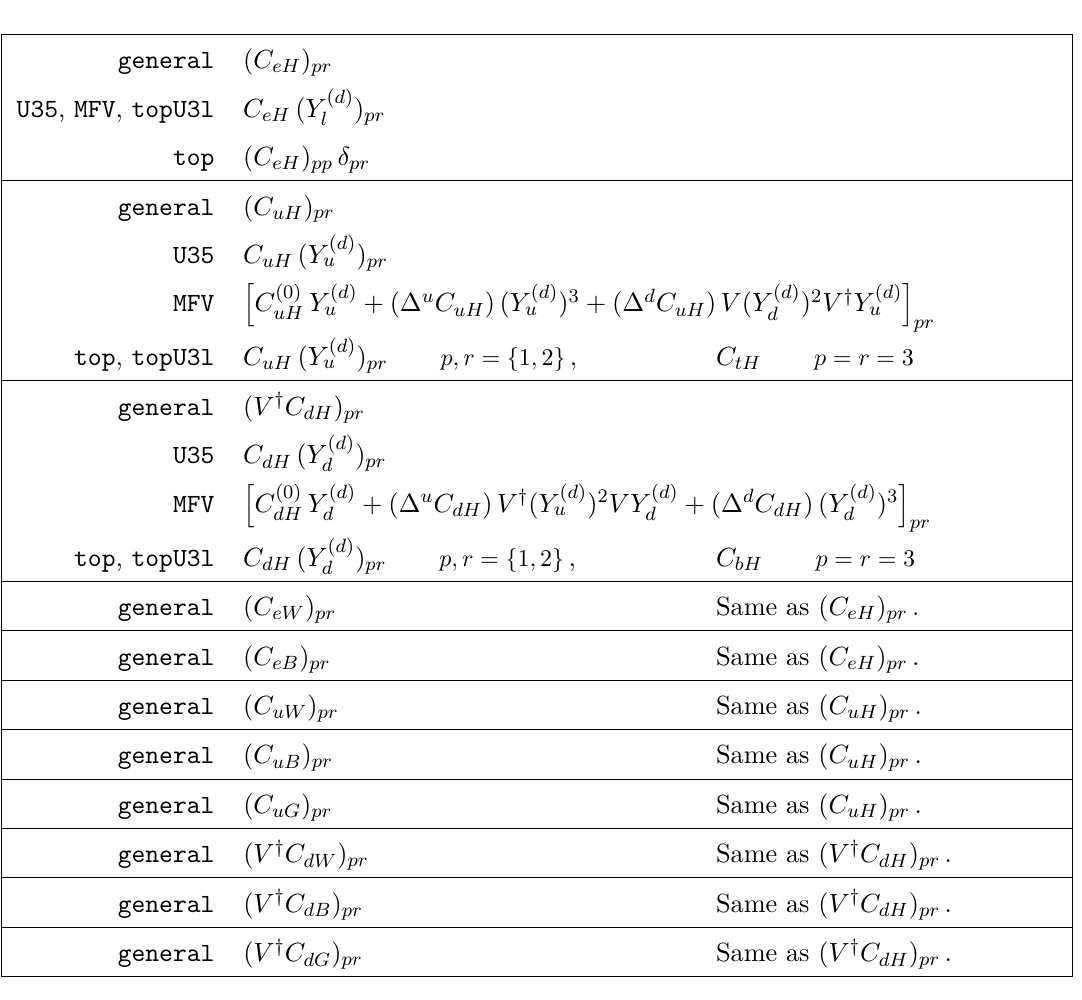
Table 10 . Conversion table among the 5 flavor assumptions considered for the operators in , L (6) L (5) 6 6